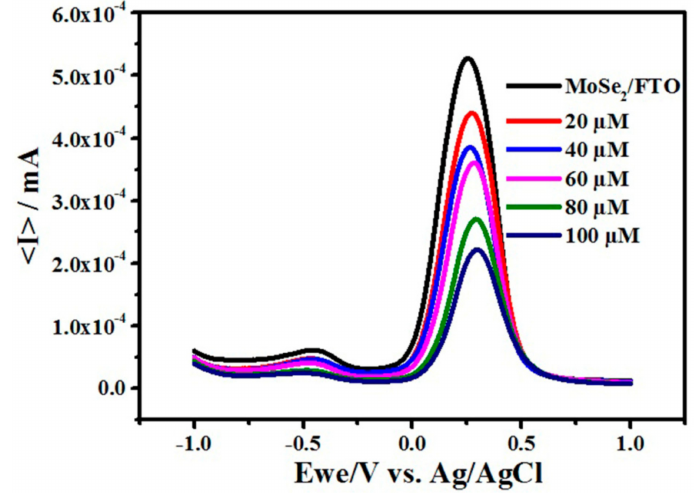
Figure 3. Differential pulse voltammogram of modified electrode at various concentrations ranging from 20 µ M–100 µ M conducted in 1 µ M MB (pH 7.4) in 0.1 M KCl at the scan rate of 100